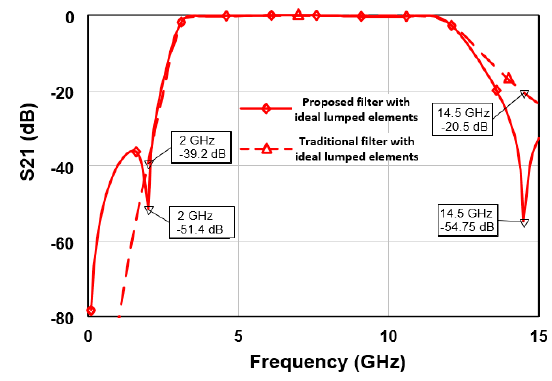
Figure 7. Simulated S21 response of the proposed and traditional filter with ideal elements.